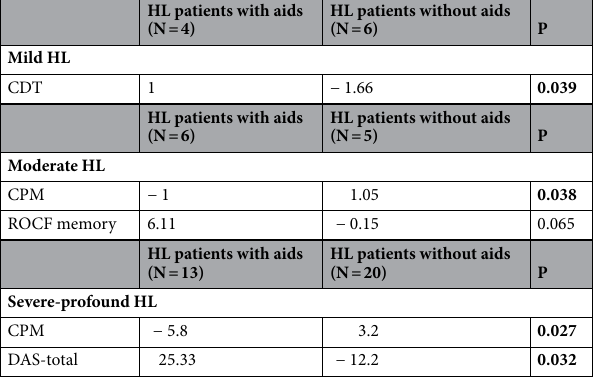
Table 3. Significant differences in delta (T1 − T0) values for neuropsychological and behavioral variables in HL patients with and without hearing aids divided according to the severity of HL . Statistically significant differences are indicated in bold. CDT, Clock Drawing Test; CPM, Raven’s Coloured Progressive Matrices; DAS, Dimensional Apathy Scale; HL, hearing loss; N, simple size; PTA, pure tone audiometric; ROCF memory, Rey-Osterrieth Complex Figure Test; T0, base-line; T1, Follow